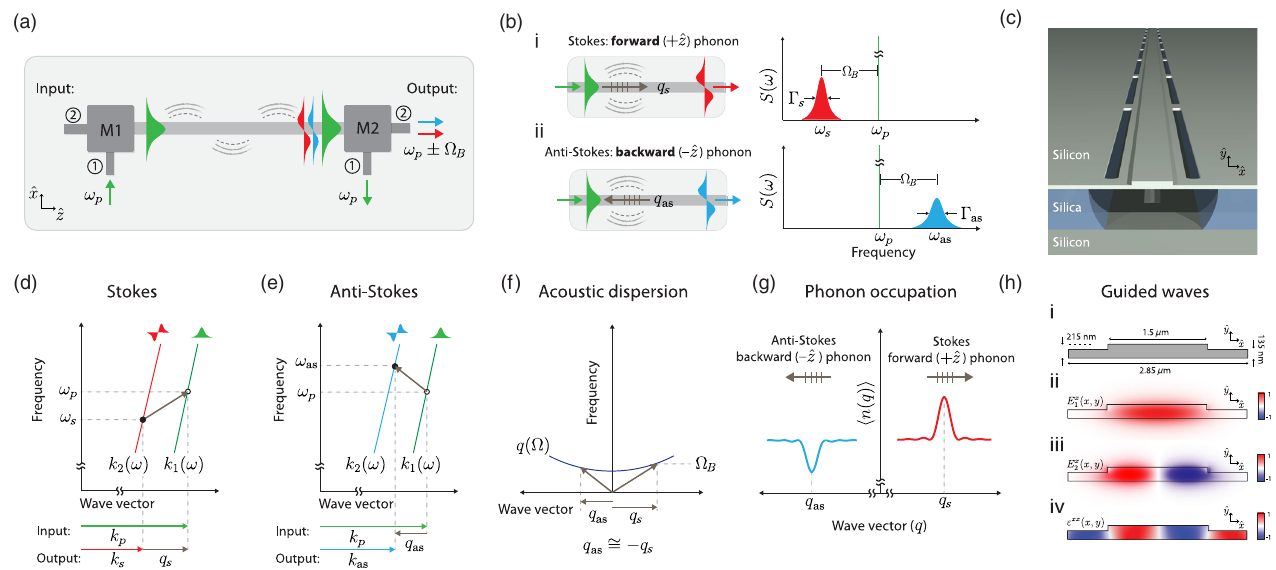
FIG. 1. Panel (a) illustrates the waveguide system and basic operation scheme. Probe light (green) of frequency ω is coupled into the p symmetric spatial mode of a Brillouin-active silicon waveguide through an integrated mode multiplexer (M1). This light interacts with forward- and backward-propagating thermal phonon fields, which produce respective Stokes (red) and anti-Stokes (blue) sidebands that propagate in the antisymmetric spatial mode. An integrated mode multiplexer (M2) then demultiplexes the scattered light for spectral analysis. (b) illustrates the optical Stokes and anti-Stokes spectra produced by spontaneous intermodal Brillouin scattering due to (bi) forward- and (bii) backward-propagating phonons, respectively. The spectral width of each sideband reveals the temporal dissipation rates and lifetimes of the phonons participating in the Stokes and anti-Stokes processes. Panel (c) depicts the suspended silicon ridge waveguide that guides both optical and acoustic waves. Panels (d) – (f) illustrate the energy-conservation and phase-matching requirements for these spontaneous Brillouin processes. (d) and (e) plot the optical dispersion relations for the symmetric and antisymmetric optical modes as well as the phonons that mediate Stokes and anti-Stokes scattering. In the Stokes process, the phonon that mediates scattering from the initial state (open circle) to the final state (closed circle) is a forward-propagating field. By contrast, as diagrammed in (e), phase matching dictates that the phonon responsible for anti-Stokes scattering must be a backward-propagating wave. These two phonons must satisfy the acoustic dispersion relation for the Lamb-like acoustic mode that mediates intermodal scattering, as shown in (f). In this system, the Stokes and anti-Stokes phonons are essentially degenerate in both Brillouin frequency and wave-vector magnitude but propagate in opposite directions. (g) This spontaneous process simultaneously reduces the thermal occupation h n ð q Þi of phase-matched backward-propagating phonons and increases that of the phase-matched forward-propagating phonons. As a result, an incident laser field drives the average momentum of the thermal bath of phonons out of equilibrium, producing a net phonon flux. (hi) diagrams the cross-sectional geometry of the hybrid photonic-phononic waveguide. Panels (hii) and (hiii) plot the x -polarized component of the TE-like symmetric [ E x 1 ð x; y Þ ] and antisymmetric [ E x 2 ð x; y Þ ] simulated mode profiles, respectively. (hiv) shows the simulated strain profile of the 6-GHz elastic mode that mediates spontaneous intermodal scattering. Here, we plot ε xx , which is the dominant component in the intermodal acousto-optic